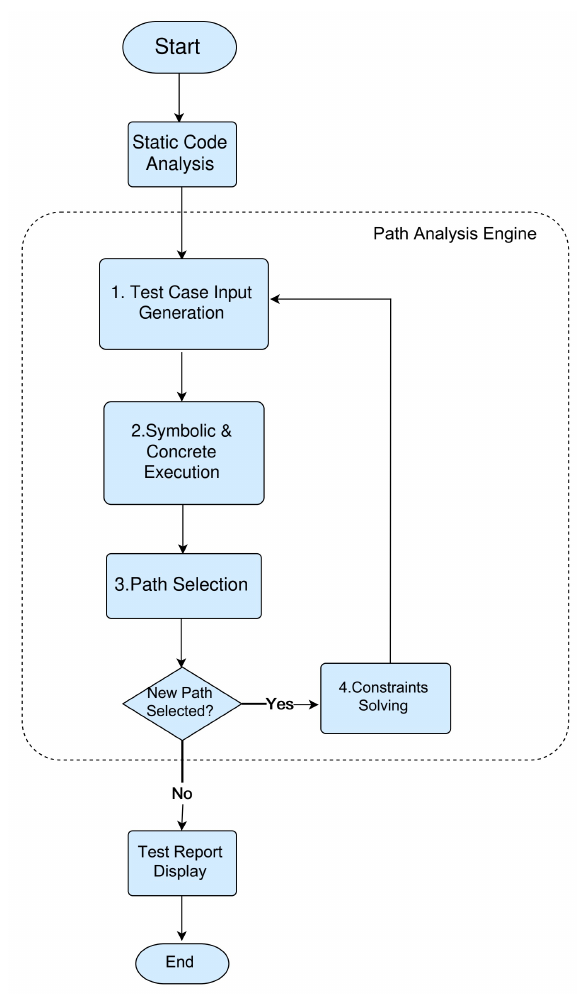
Figure 4. Test case generation